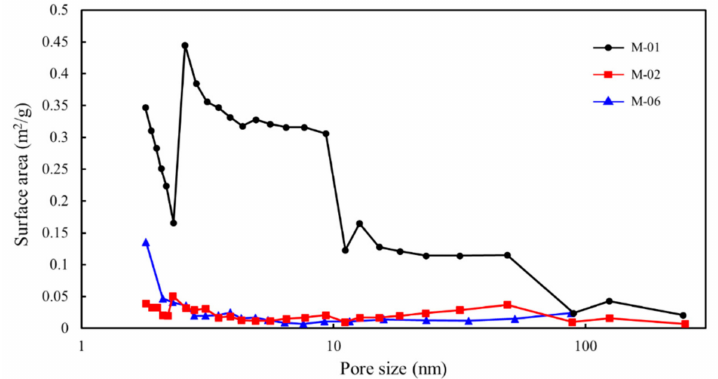
Figure 9. Surface area of di ff erent pore sizes.